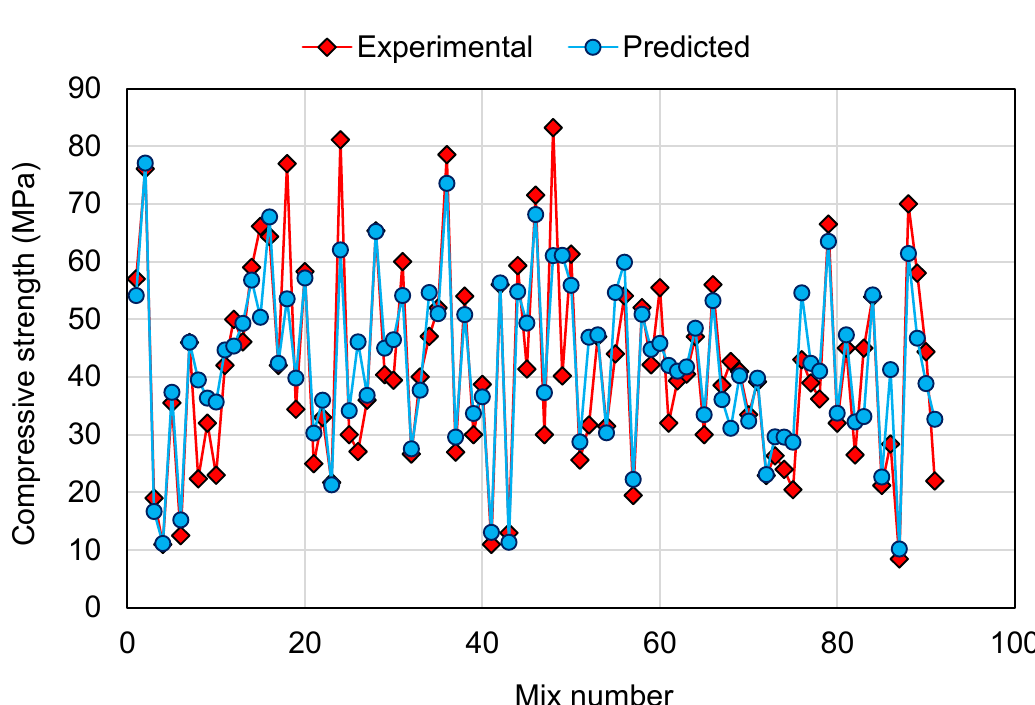
Figure 15. Comparison of experimental and predicted results for the AdaBoost model.